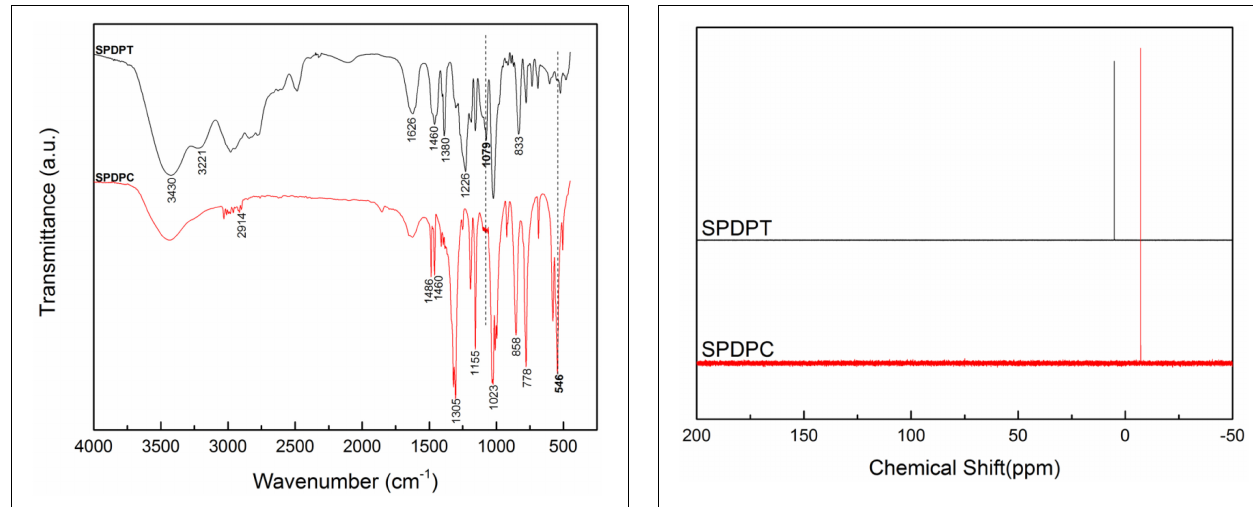
FIGURE 4 | 31 P NMR spectra of SPDPC and SPDPT.